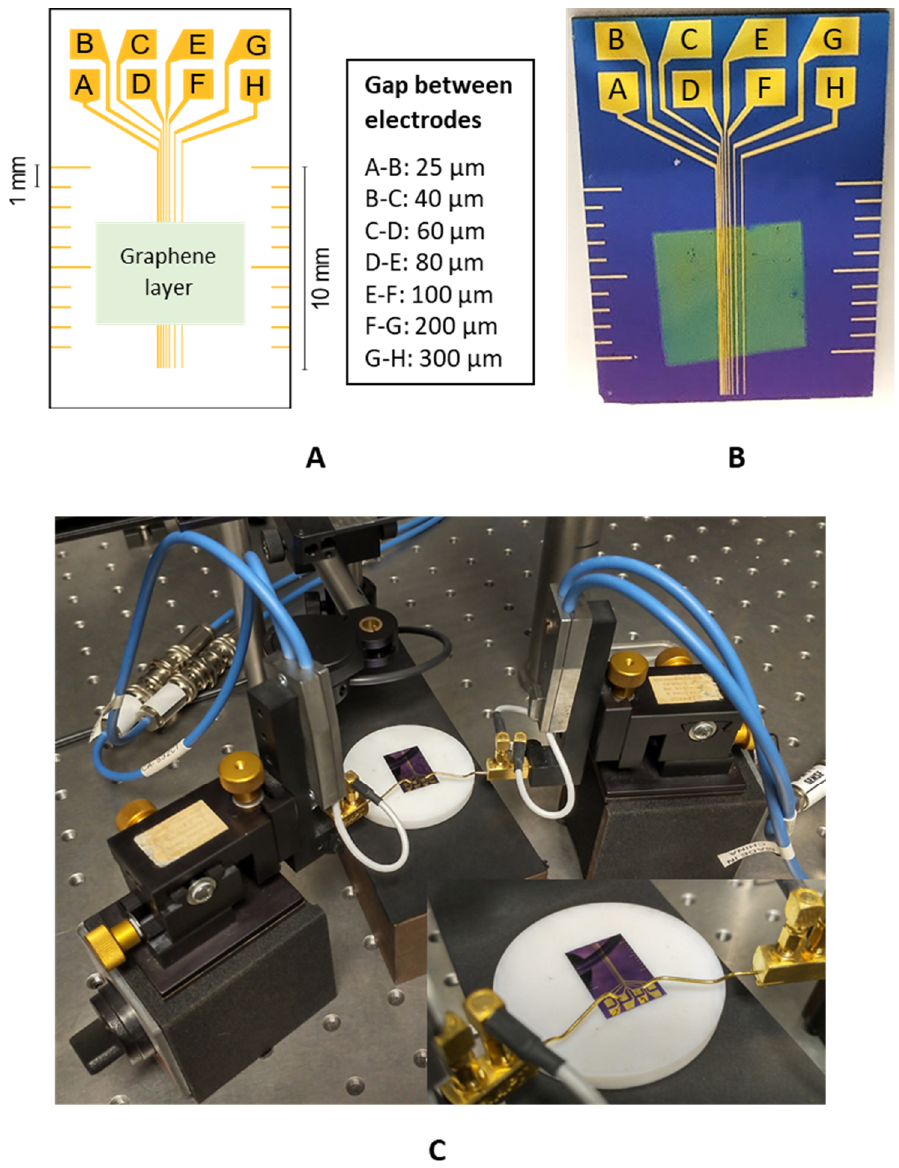
Figure 1. ( A ) Design of the electrode structure for the TLM; ( B ) realisation of the electrode structure on the Si wafer; ( C ) measurement configuration.